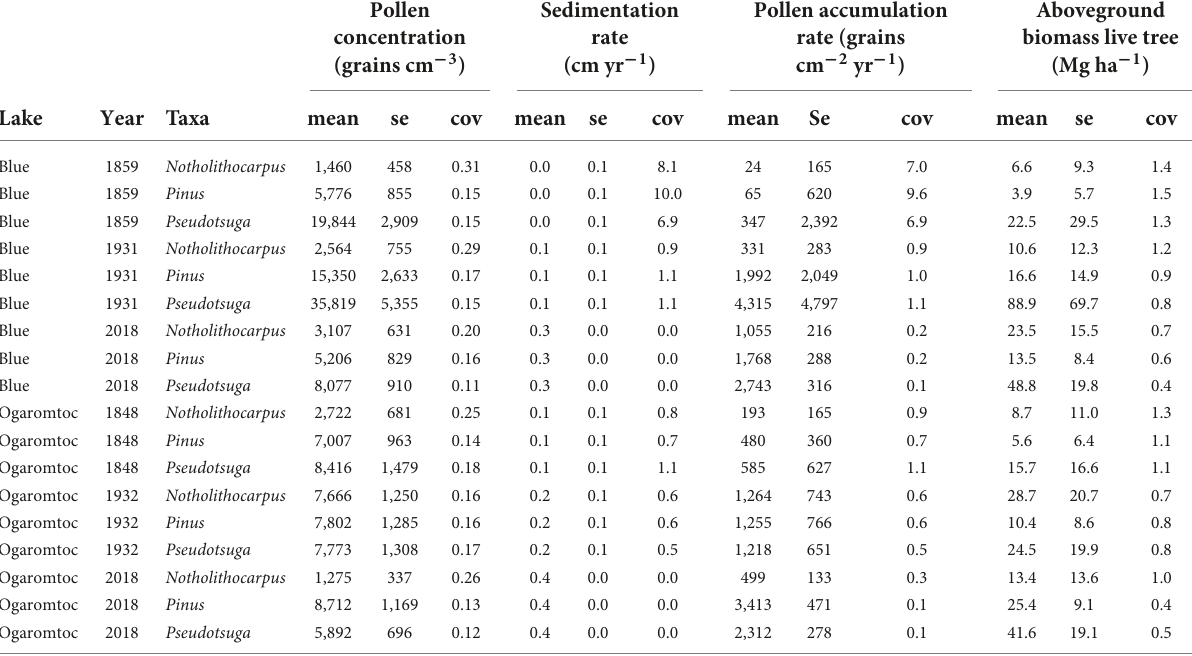
TABLE 2 Examples of the uncertainty associated with each step in the reconstruction of aboveground live tree biomass from pollen accumulation rates for seven lakes in the Klamath bioregion of California. Pollen Sedimentation Pollen accumulation Aboveground concentration rate rate (grains biomass live